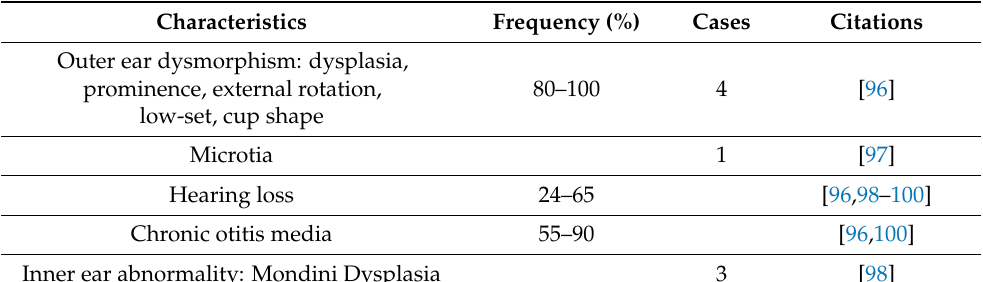
Table 1. Ear dysmorphism in Kabuki syndrome (KS) patients reported in the